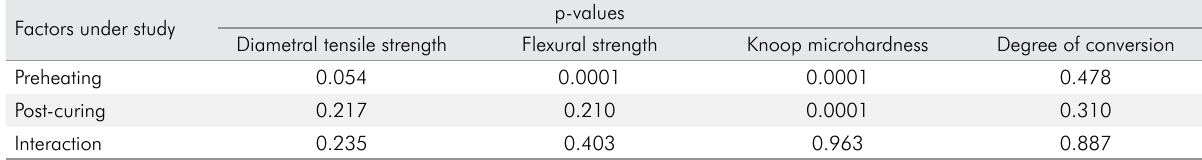
Table 3. Univariate factorial analysis of variance ( α = 0.05) for each variable (diametral tensile strength, flexural strength, knoop microhardness, conversion degree) under